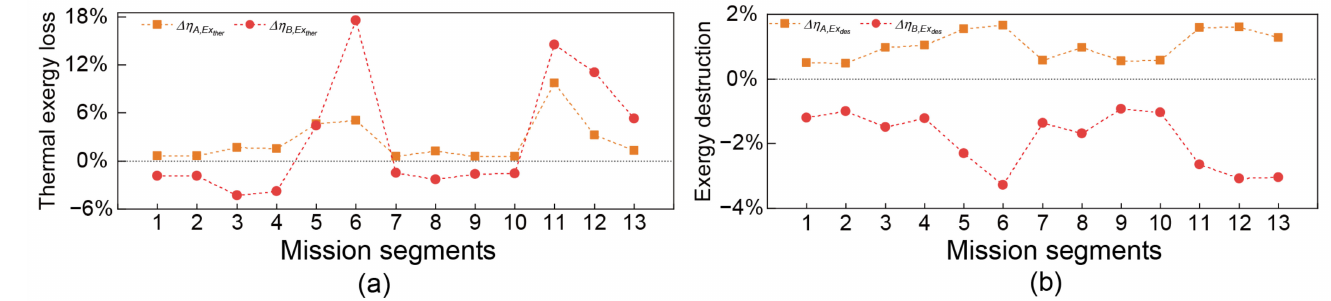
Figure 9. Variation of the exergy destruction and thermal exergy loss in scheme A and B. ( a ) Thermal exergy loss; ( b ) Exergy